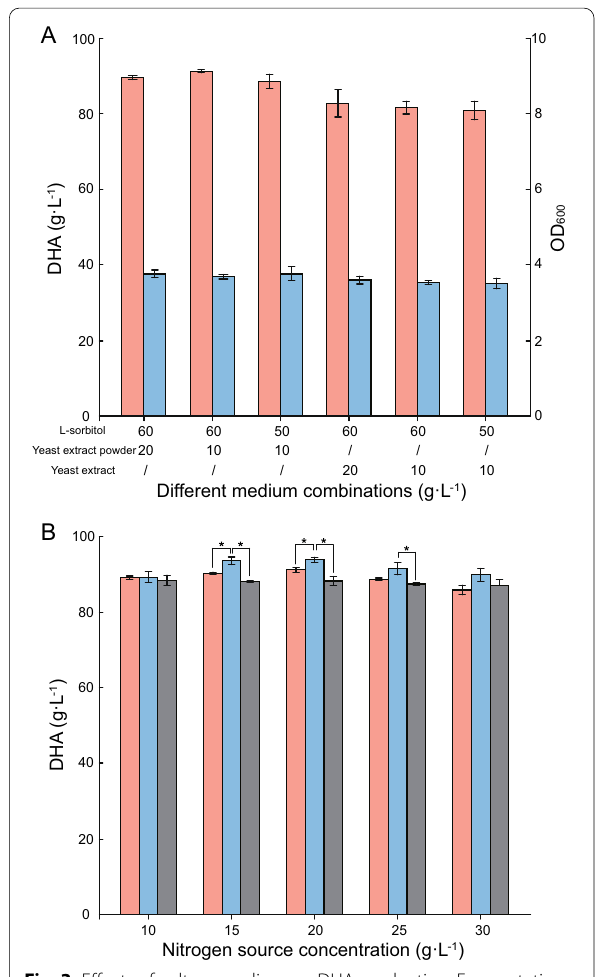
Fig. 3 Effects of culture medium on DHA production. Fermentation of engineered strain G. oxydans WSH-003–4 was conducted with 100 g L − 1 initial glycerol in 500 mL shaking flasks for 72 h. A Optimization of seed culture medium. Pink; DHA production; Blue; OD 600 . B Comparing different nitrogen sources in fermentation medium. Significant differences in DHA production between the yeast extract and other two nitrogen sources (yeast extract powder and corn steep liquor) were analyzed using student’s T tests (* p 0.05, ** p 0.01). Pink; yeast extract powder, Blue; yeast extract, ≤ ≤ Gray; corn steep